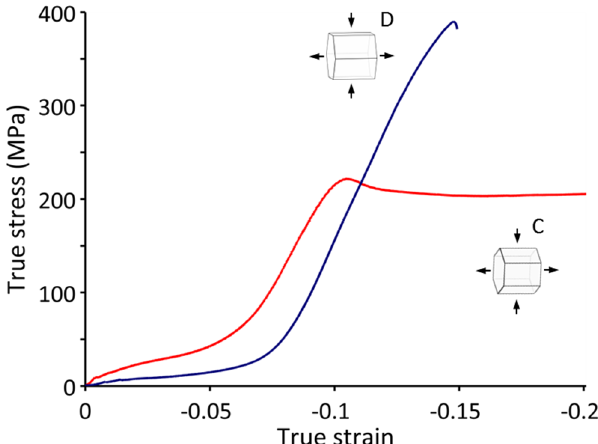
Figure 9. Flow curves of pure Mg single crystals of orientations C and D ( c -axis extension) deformed by PSC at ambient temperature and a constant strain rate of 10 − 3 s − 1 . Oil was used for lubrication.